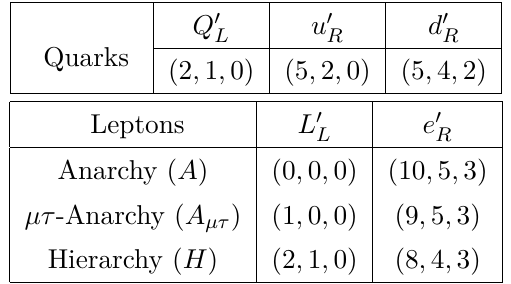
Table 1 . FN charge assignments for realistic scenarios with (cid:15) = 0 . 23